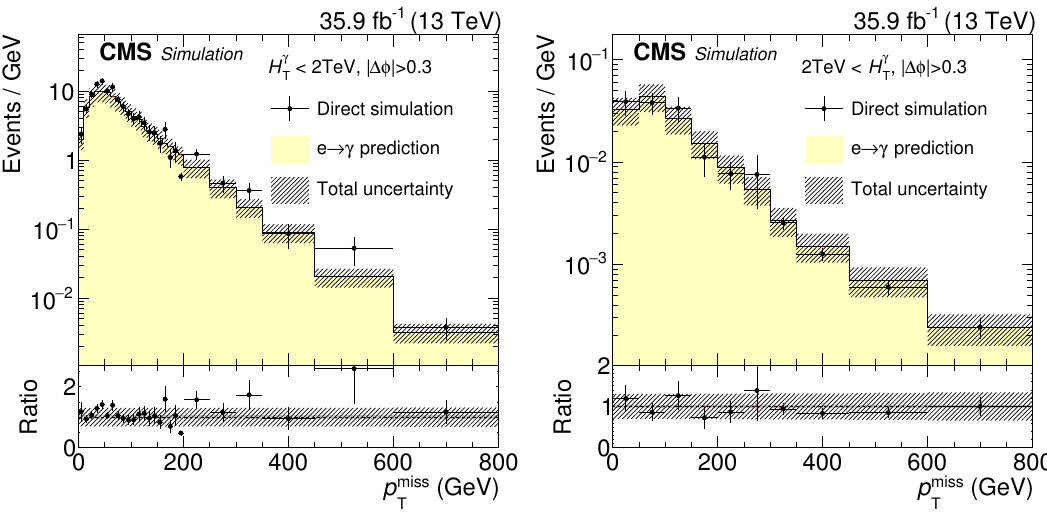
Figure 3 . Validation of the background estimation method for electrons misreconstructed as photons using W+jets and tt simulation. The low- (high-) H (cid:13) (right). The number of events corresponds to the expectation in data for an integrated luminosity of 35.9 fb (cid:0) 1 . The rightmost bin includes all events with p miss